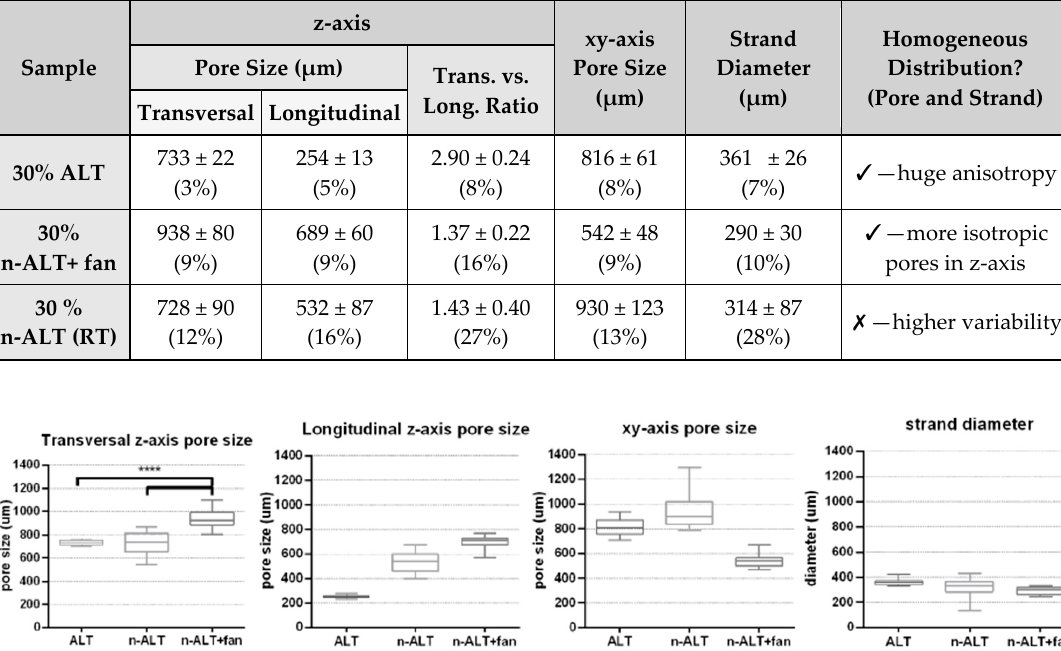
Figure 5. Box and whiskers plot for pore sizes measured with ImageJ at z- axis (transversal = horizontal, longitudinal = vertical) and at xy-axis (in any direction between parallel walls), along with the strand diameter. (n = 3 samples with at least 4 measurements per sample, mean ± SD, **** p < 0.001).